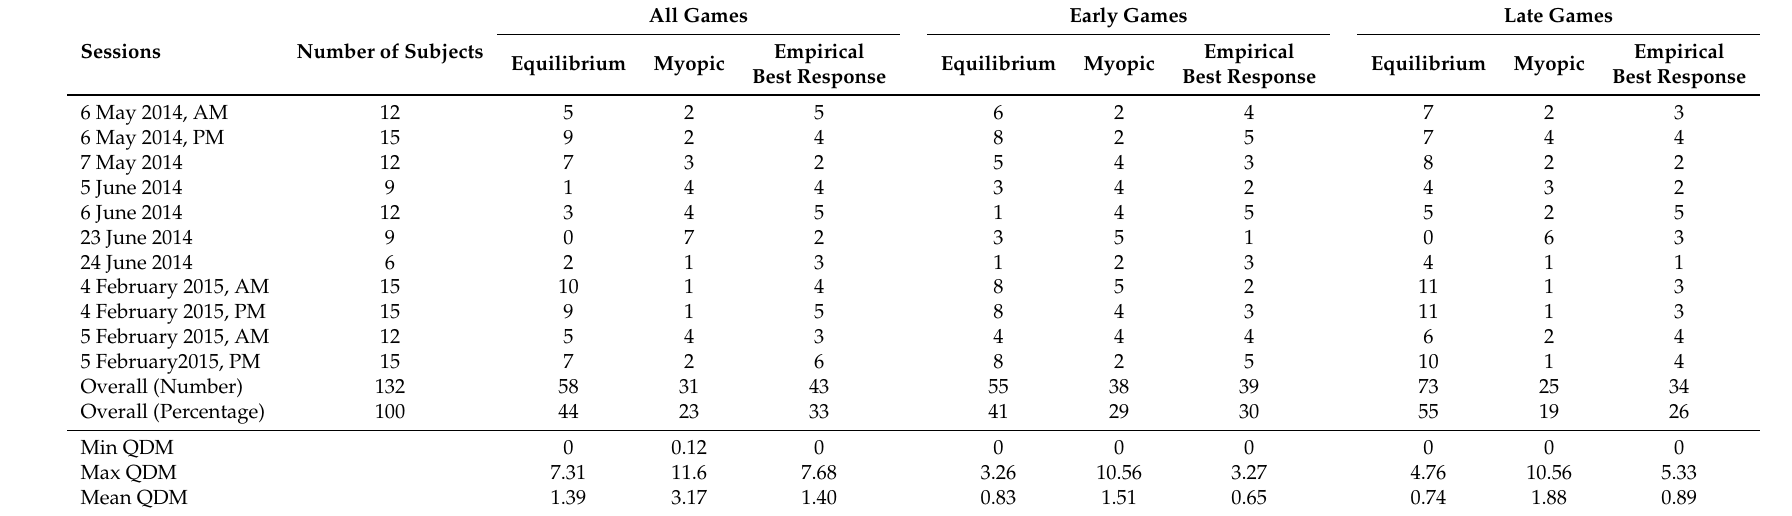
Table 6. Subject type by session for all games, early games, and late